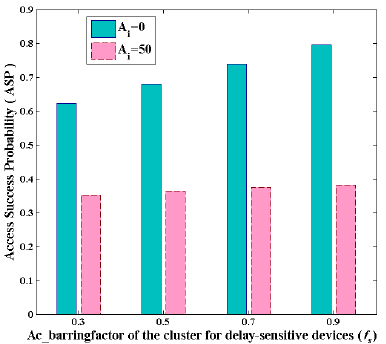
Figure 4. The access success probability (ASP) of two extreme cases versus f s during one